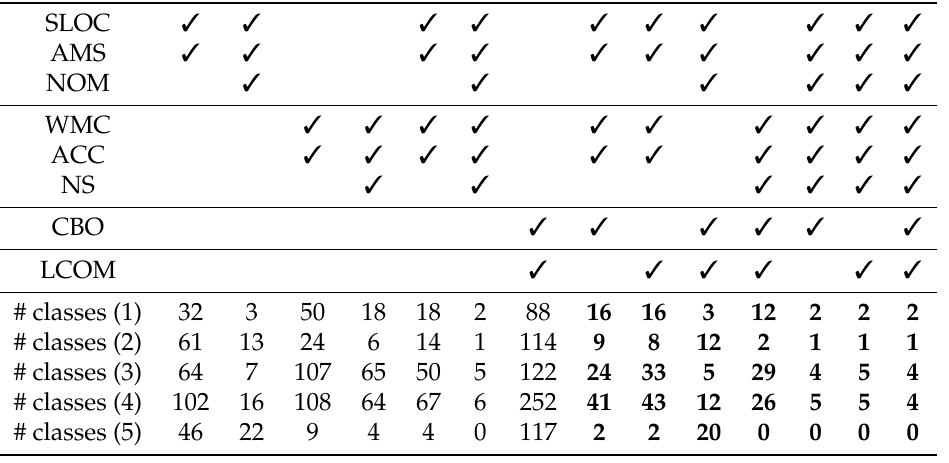
Table 8. Number of identified classes within KeePass (1); OpenCBS (2); iTextSharp (3); OnlyOffice (4) and Git Extensions (5) using a combination of software